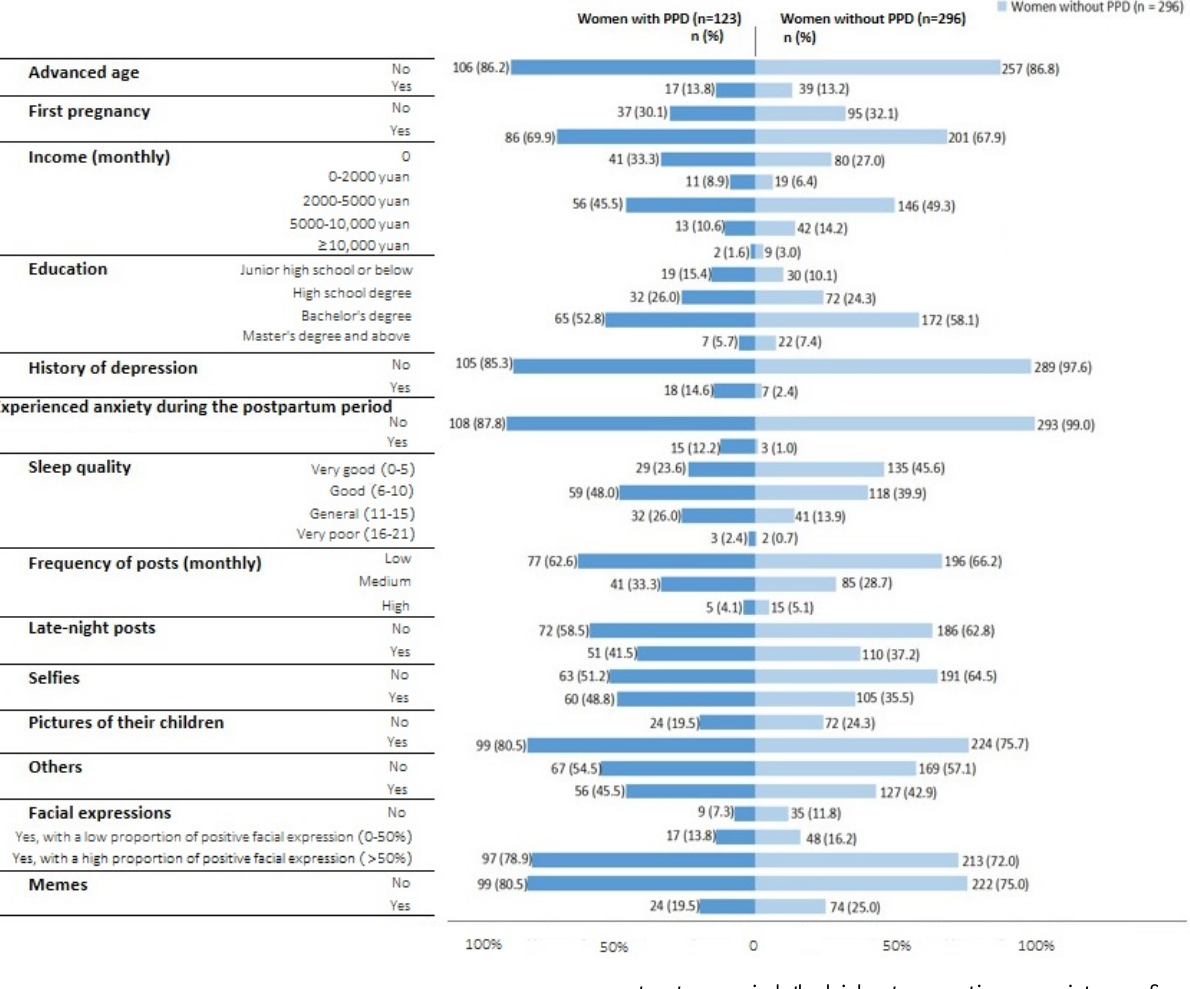
Figure 2. Characteristics of women with or without postpartum depression. PPD: postpartum